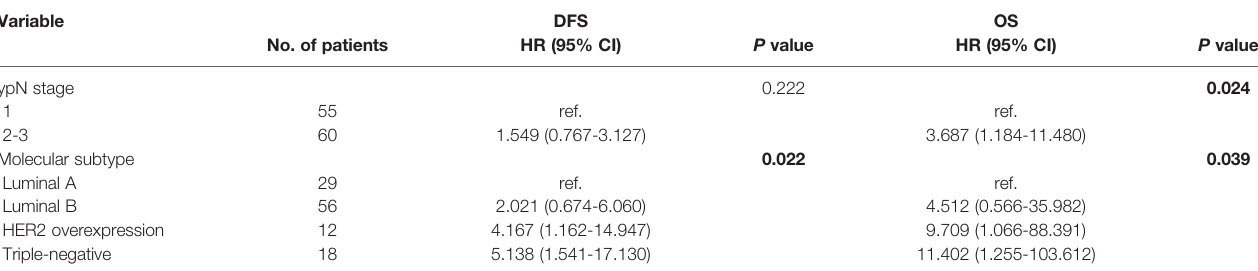
TABLE 5 | Multivariate analysis of factors associated with DFS and OS in the ypT 0-2 N + PMRT subgroup.